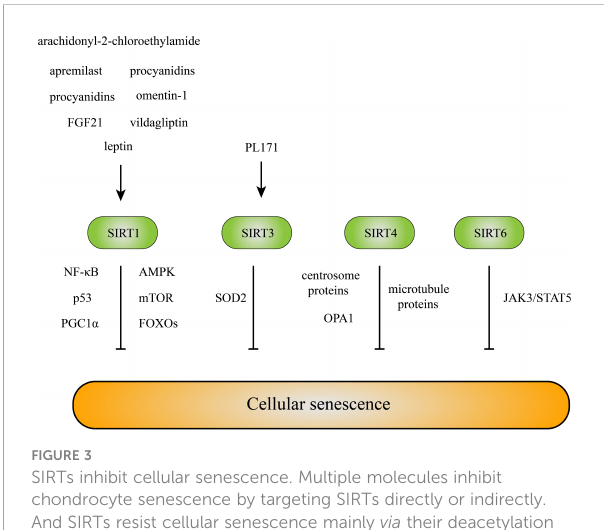
FIGURE 3 SIRTs inhibit cellular senescence. Multiple molecules inhibit chondrocyte senescence by targeting SIRTs directly or indirectly. And SIRTs resist cellular senescence mainly via their deacetylation effects on the downstream molecules and signaling